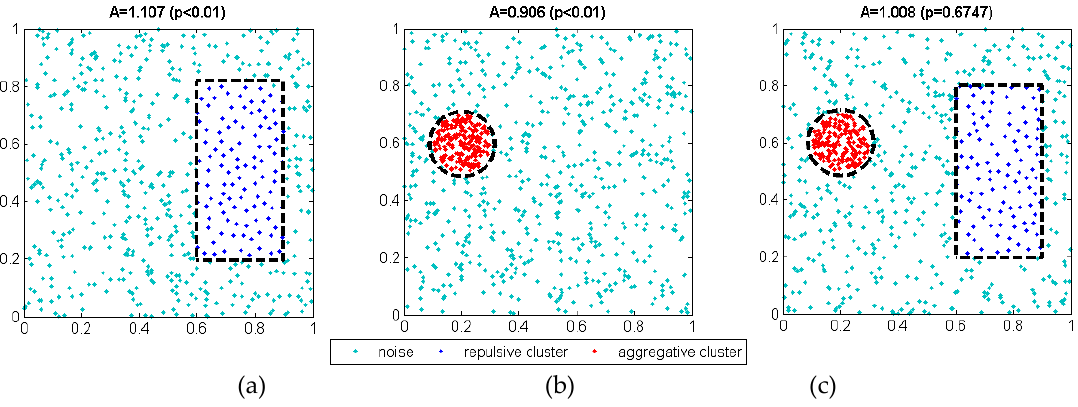
Figure 2. Comparison of point processes with different components. ( a ) Noise and a repulsive cluster; ( b ) noise and an aggregative cluster; and ( c ) noise, a repulsive cluster and an aggregative cluster.